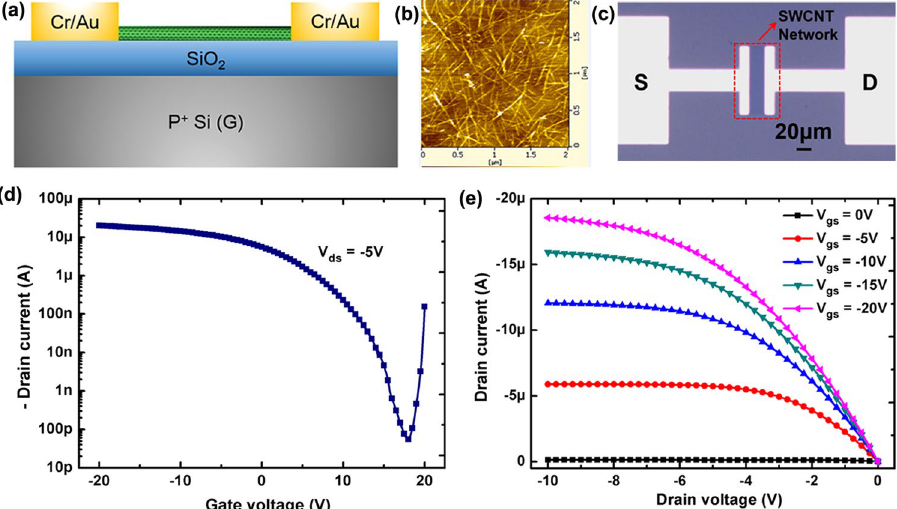
Figure 1. Structural and electrical characterization of back-gated CNFET devices before DMC n-doping. ( a ) The cross-sectional view of a back-gated CNFET device. ( b ) AFM image of the deposited carbon nanotube network on SiO 2 /Si substrates. ( c ) the optical image of a representative CNFET device. ( d ) Transfer I ds - V gs and ( e ) output I ds - V ds curves of a back-gated CNFET device which show p-channel transistor behaviors due to oxygen